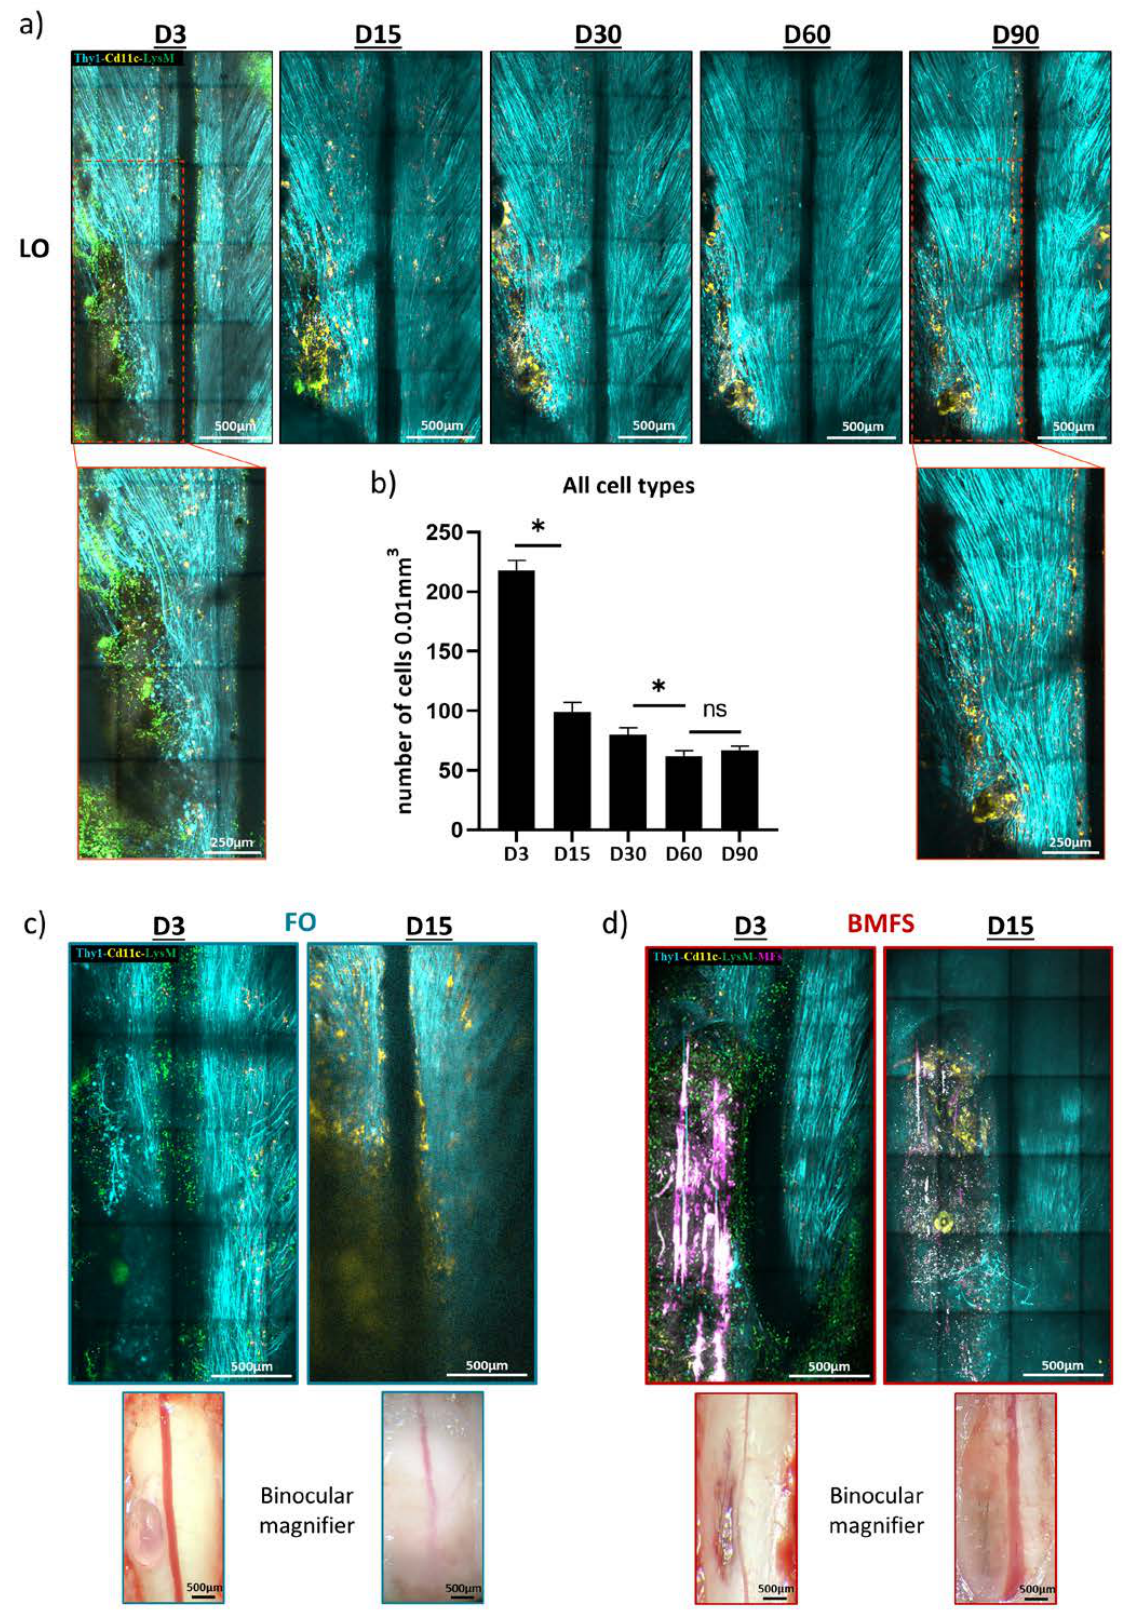
Figure 3. Degradation of the fibrin matrix triggers fast opacification of the window precluding longitudinal intravital 2P imaging. ( a ) Representative maximal intensity projection of 2P z-stack